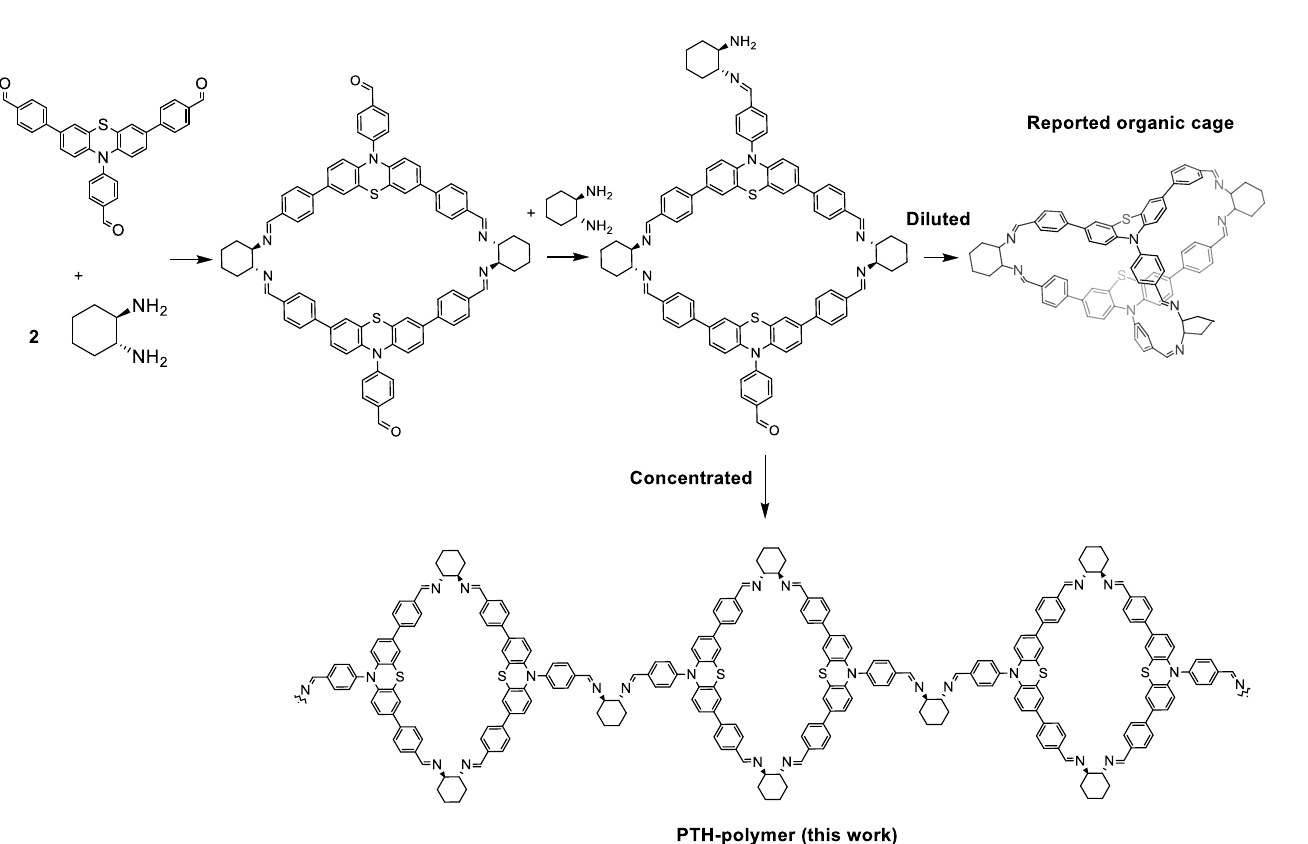
Figure 4. Absorption (gray) and emission (black) spectra of PTH-polymer. 2.2. Photocatalytic Activity The appealing optical properties of the material obtained and the fact that it is iso- lated as a transparent film prompted us to apply it as photocatalytic membrane in solvent- free processes. To this end, we chose aerobic sulfoxidation as a model reaction, which has been observed in related systems using organic solvents [24,36,37]. In this work, sulfoxi- dation reactions were carried out in absence of solvent, which is a challenging goal for photocatalytic transformations. With this aim, the catalytic system consisted of a liquid organic sulfide that directly contacted with the material surface irradiated with a blue a)